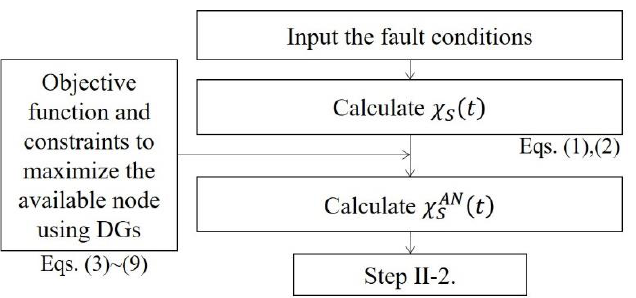
Figure 4. Estimation process of the resilience curve.